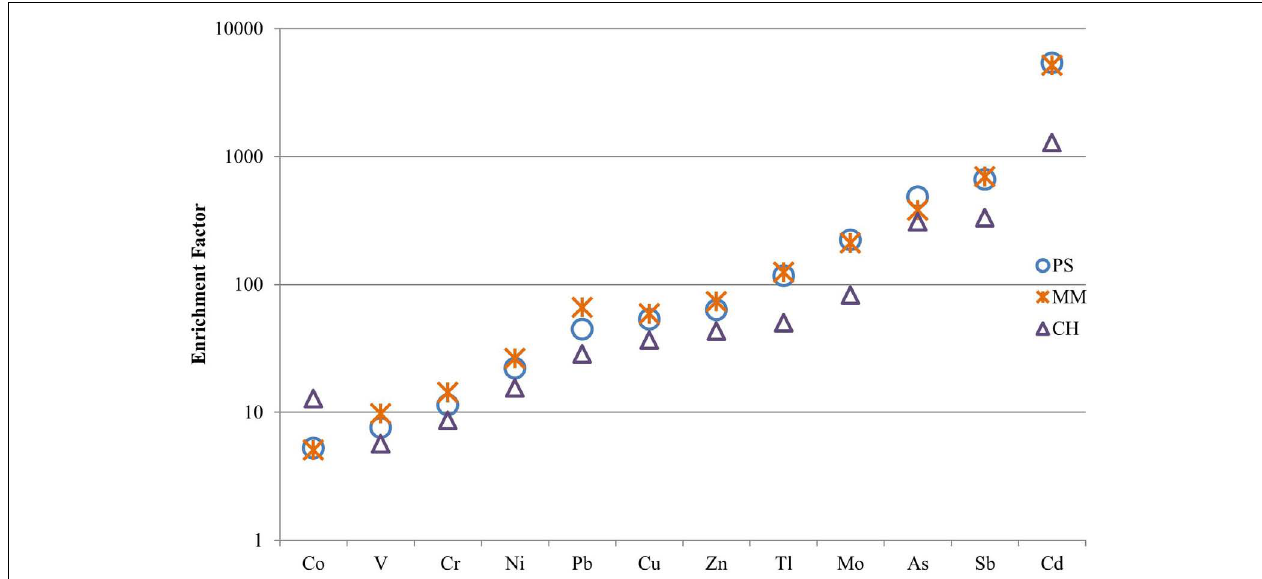
FIGURE 3 | EFs for all the analyzed elements in the three